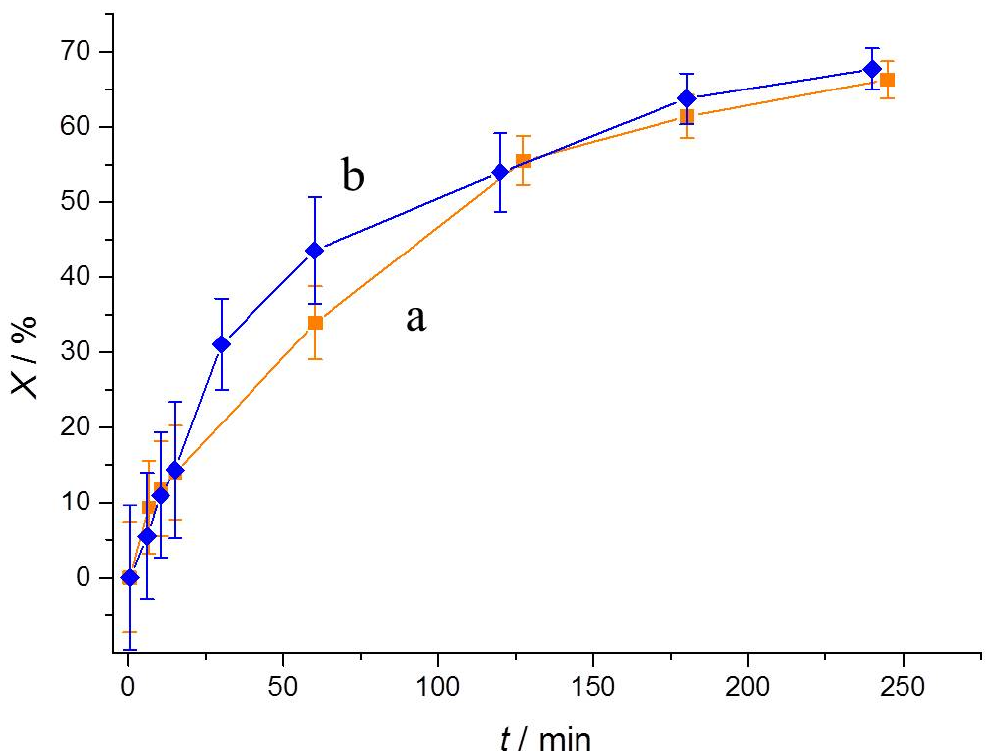
Figure 9. Benzyl alcohol conversion as a function of reaction time for ( a ) Au ‐ DDA/ γ‐ Al 2 O 3 and ( b ) Au ‐ DDA/ γ‐ Al 2 O 3 (O 3 8 h).